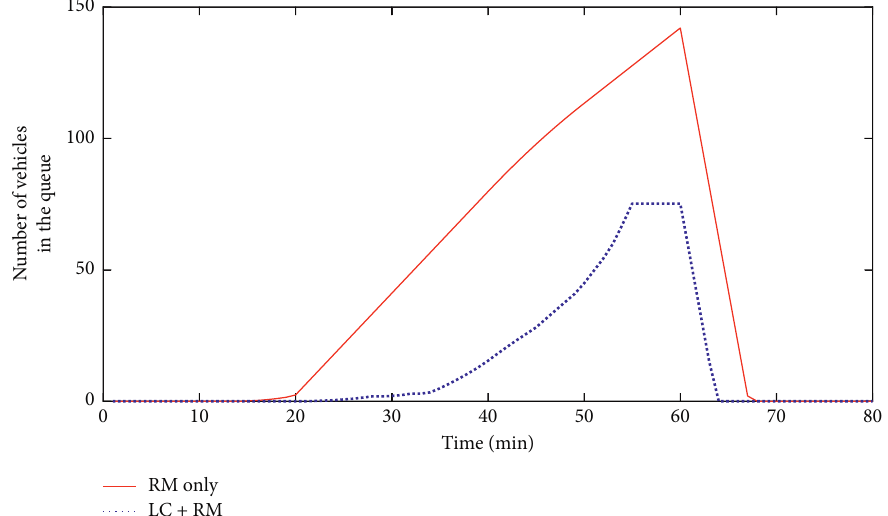
Figure 7: Queue length at the